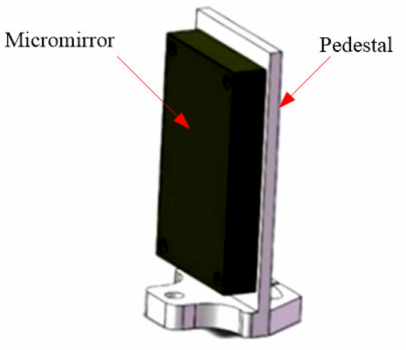
Figure 18. The components of the MOEMS scanning grating mirror.